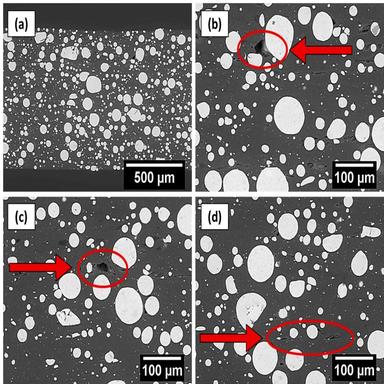
(a-d) SEM of cross-sectioned BST/ABS 3D printed test samples at 50.27 wt% (15.26 vol%). The arrows denote the defects responsible for hampering the dielectric and physical properties.